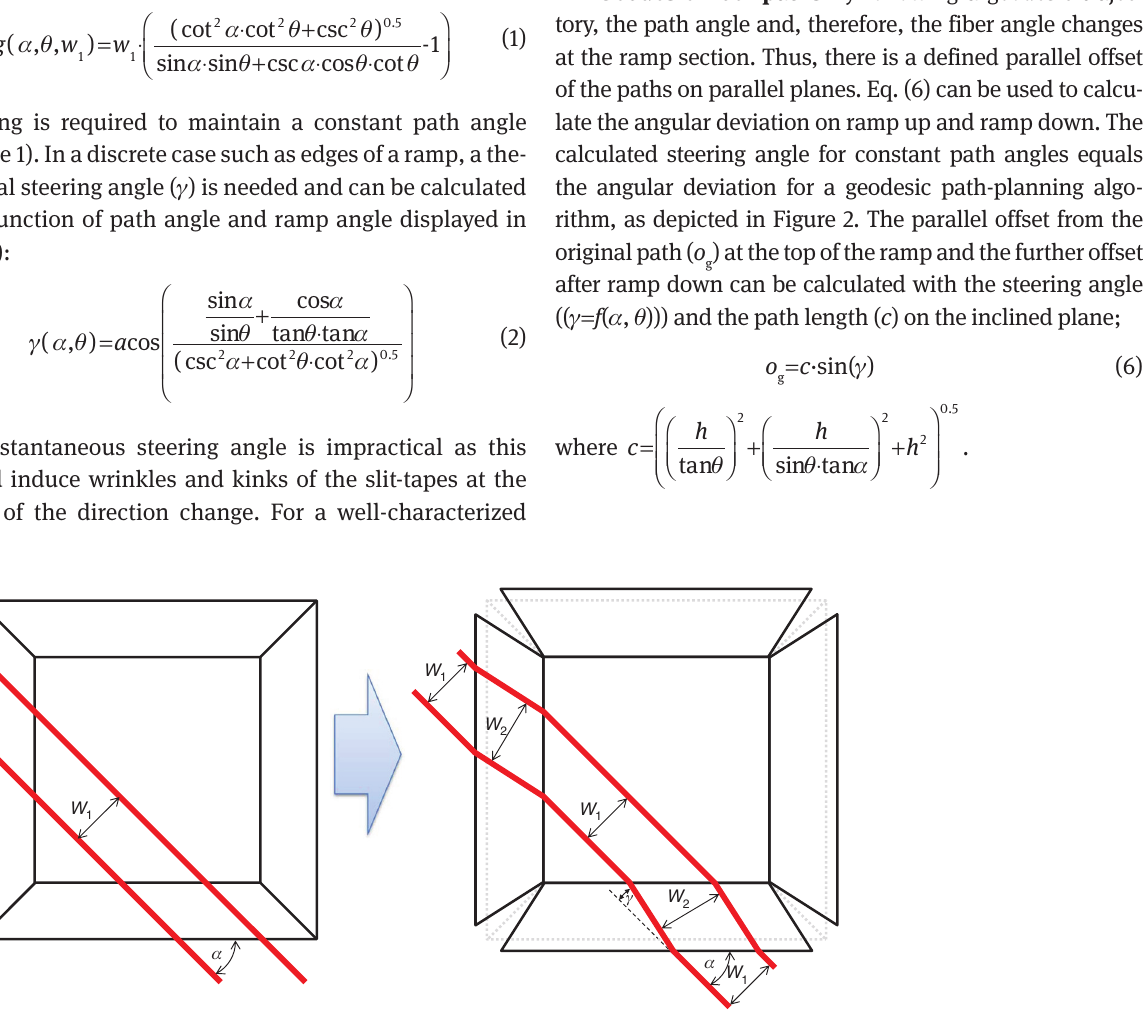
Figure 1 Projected path for constant angle paths on a ramped structure (left) with the flat projection